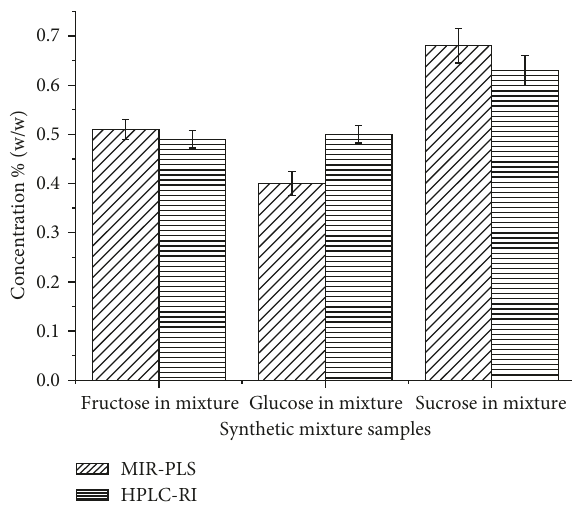
Figure 4: Comparison of MIR-PLS with